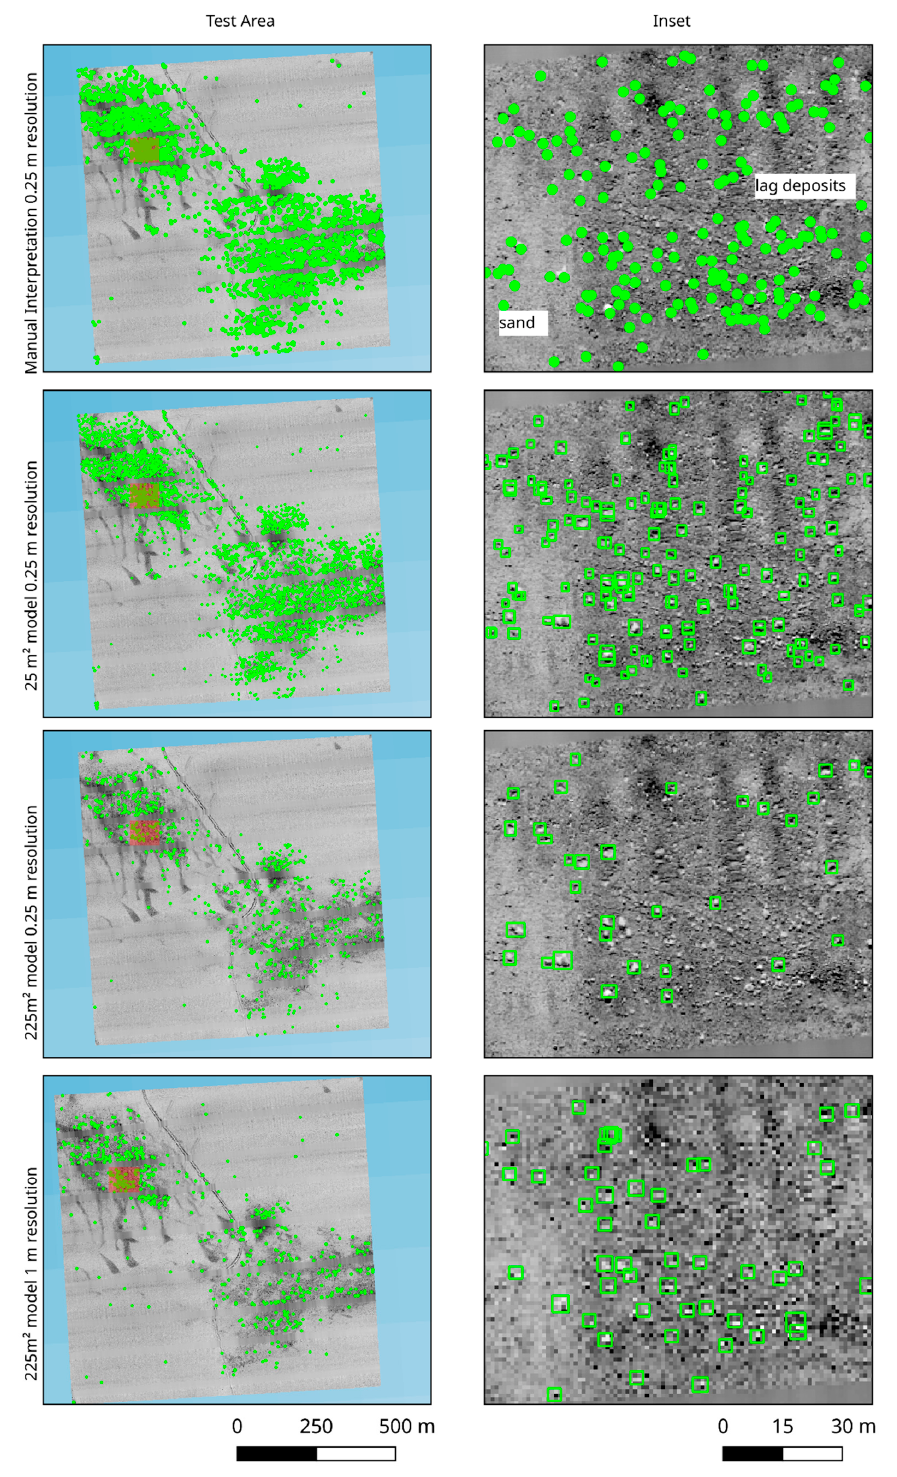
Figure 4. Boulders (green boxes and dots) detected manually and by the 25 m² and 225 m² model trained on backscatter mosaics with 0.25 m and 1.0 m resolution. For the manual interpretation of the test mosaic, no bounding boxes are available.